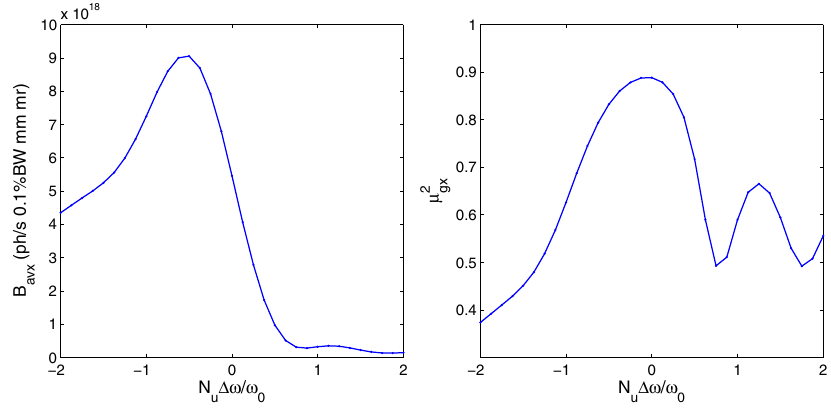
FIG. 18. The average 2D brightness B